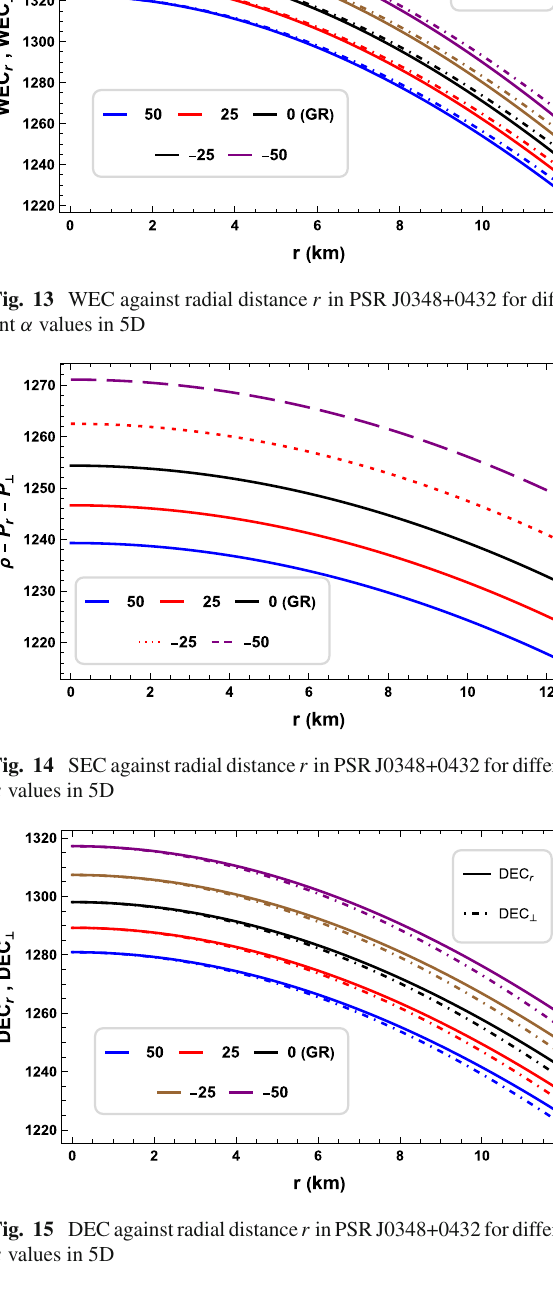
Fig. 16 Nature of EoS in PSR J0348+0432 for α equals to 50 , 25 , 0 , − 25 , − 50 (in order of left to right in fig.) in